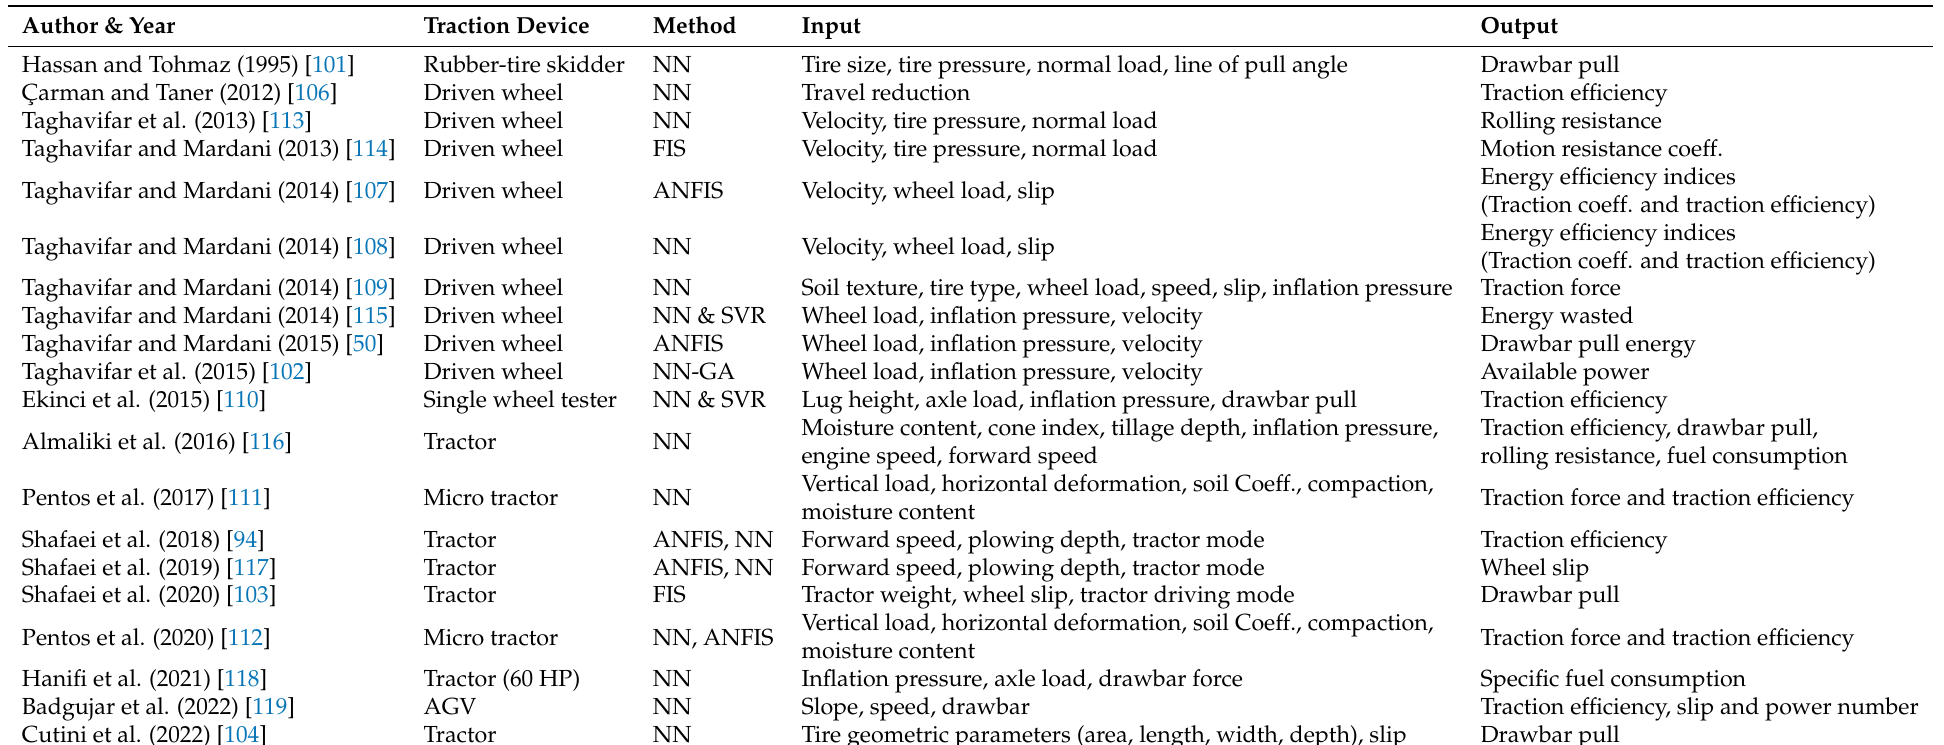
Table 1. Traction studies which employed the CI